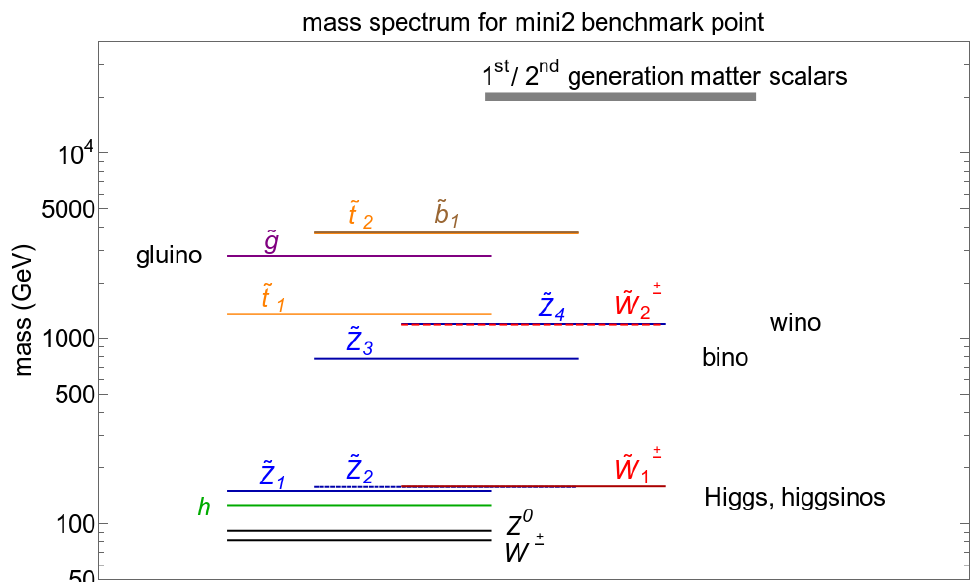
Figure 7 . The superparticle mass spectra from the natural mini-landscape point mini2 of table 1.